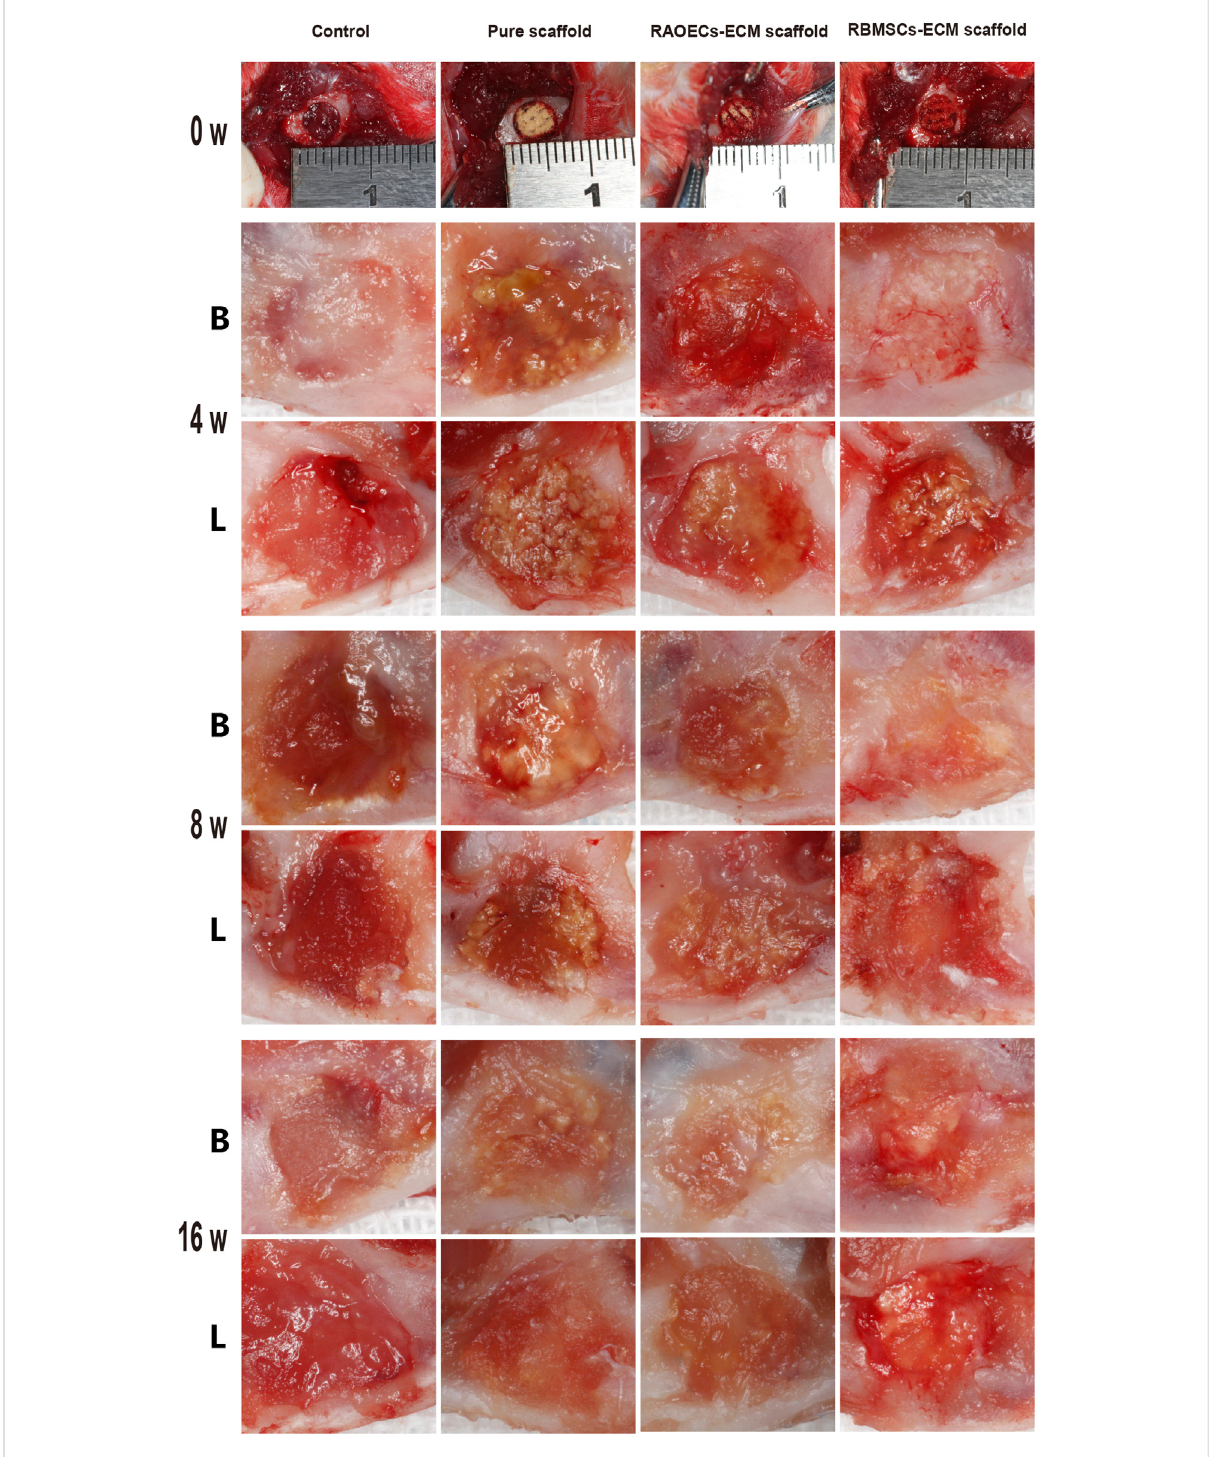
FIGURE 3 Photographs of the surgical procedure and postoperative healing. The structural integrity of all the scaffolds was maintained during surgery. At 4, 8 and 16 weeks after surgery, the defect sites of each group were observed from buccal (B) and lingual (L)